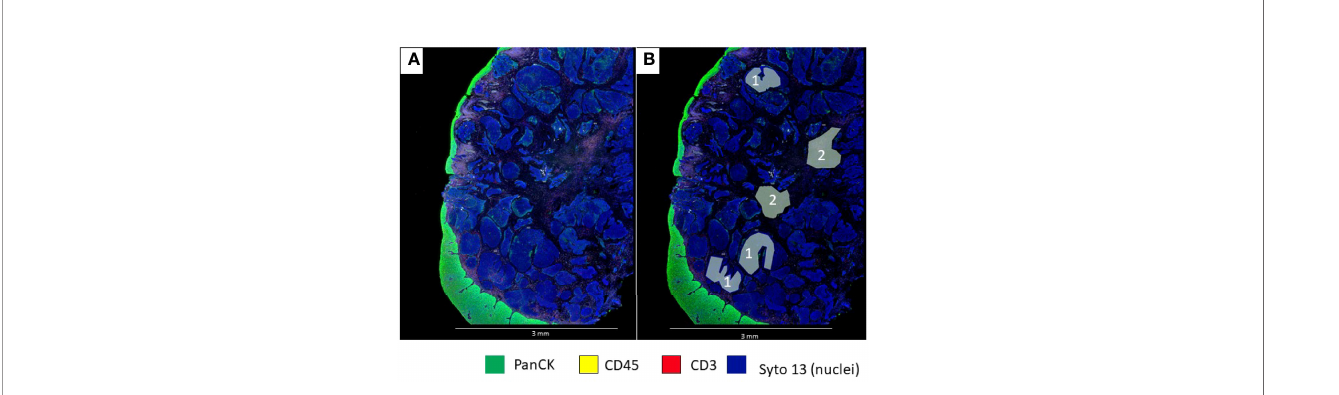
FIGURE 3 | Microphotographs showing a section of a biopsy with invasive basaloid rectal carcinoma tissue. (A) , Multiplex immuno fl uorescence performed with DSP assay highlight epithelial cells with PanCK (green) and nuclei with Sytol3(Blue), Carcinoma nests showed low levels of panCK expression while super fi cial squamous epithelium shows strong panCK expression, (B) Marked up image showing ROI selection in tumor cells and tumor stroma, ROI strategy to identify carcinoma from tumor stroma is only possible with non-segmented